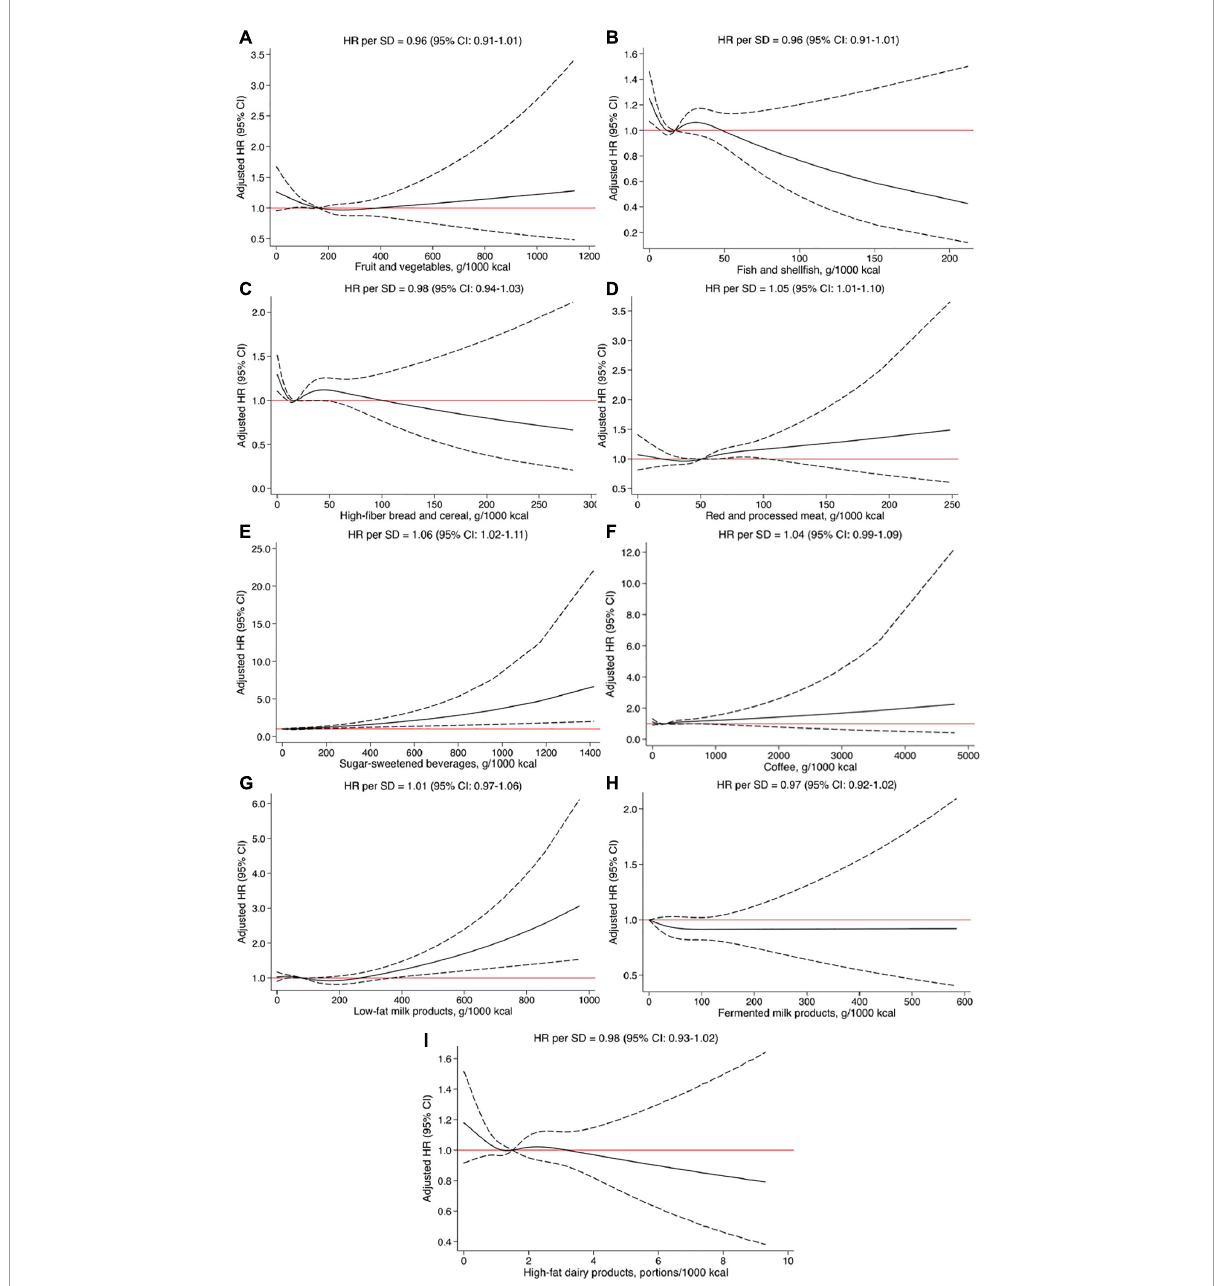
FIGURE2 (A–I) Restricted cubic splines fitted to Cox regression models showing the associations between dietary intakes and risk of atherothrombotic ischemic stroke. Solid line represents the adjusted hazard ratio (HR) and dashed lines the 95% confidence intervals (CI). All models were adjusted for age, sex, educational level, and smoking